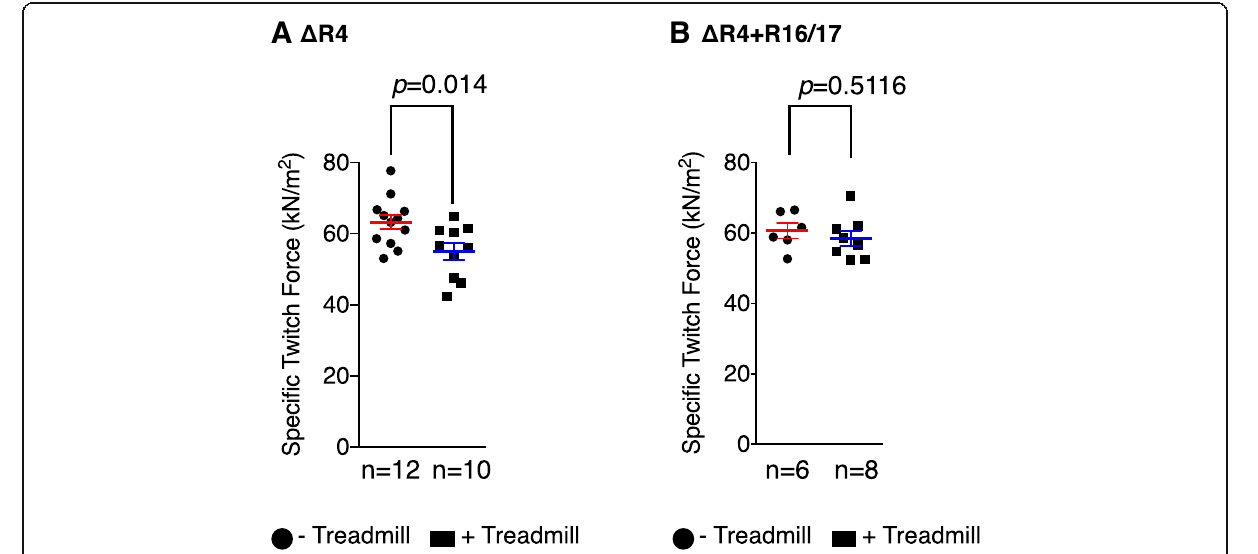
Fig. 5 R16/17.GFP.Pal protein transfer improves muscle function of Δ R4 mice. Δ R4 mice injected with R16/17 protein were subjected to